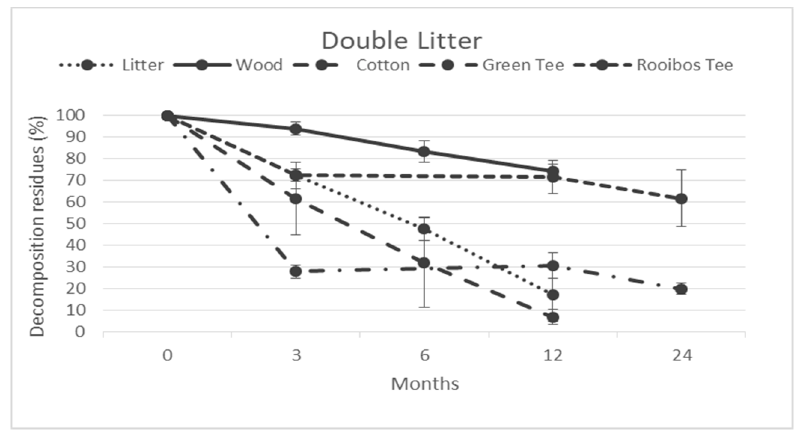
Figure 7. Decomposition rate of different quality organic matter after 3, 6, 12 and 24 months in the soils of No Litter (NL) plots of the DIRT experiment (average of 9 replicates with standard deviation).